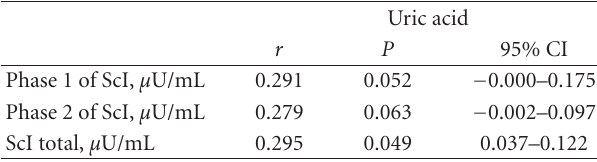
Table 3: Correlation between uric acid and insulin secretion phases.